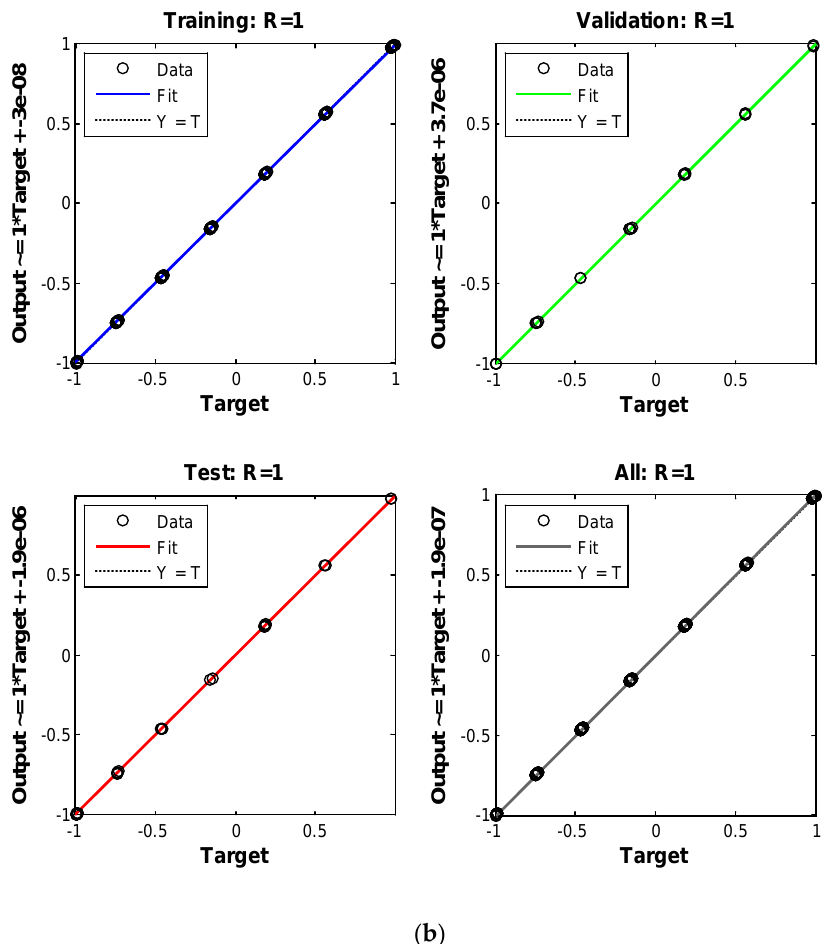
Figure 9. GAANN correlation performance: ( a ) ANN models for predicting equivalent rates; ( b ) ANN models for predicting torque factors.